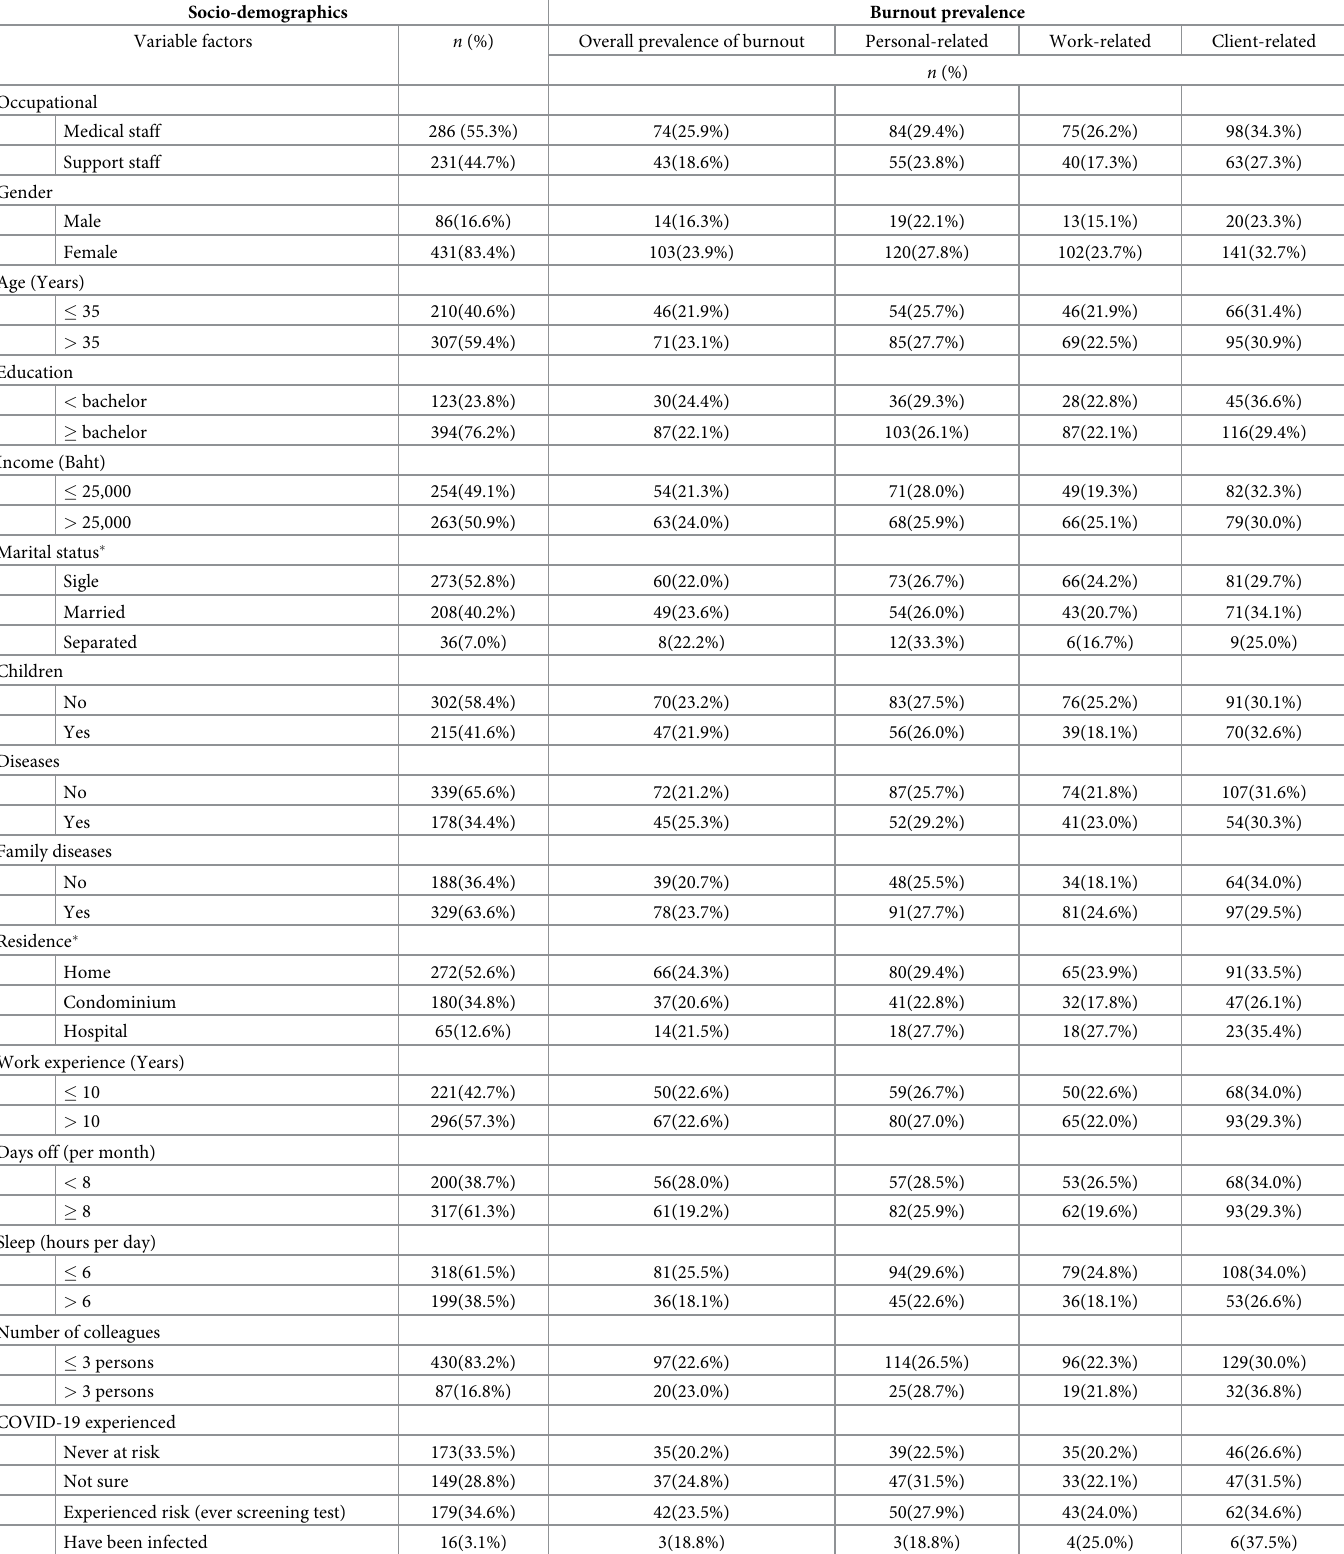
Table 1. Demographic characteristics and burnout prevalence among healthcare workers (n =